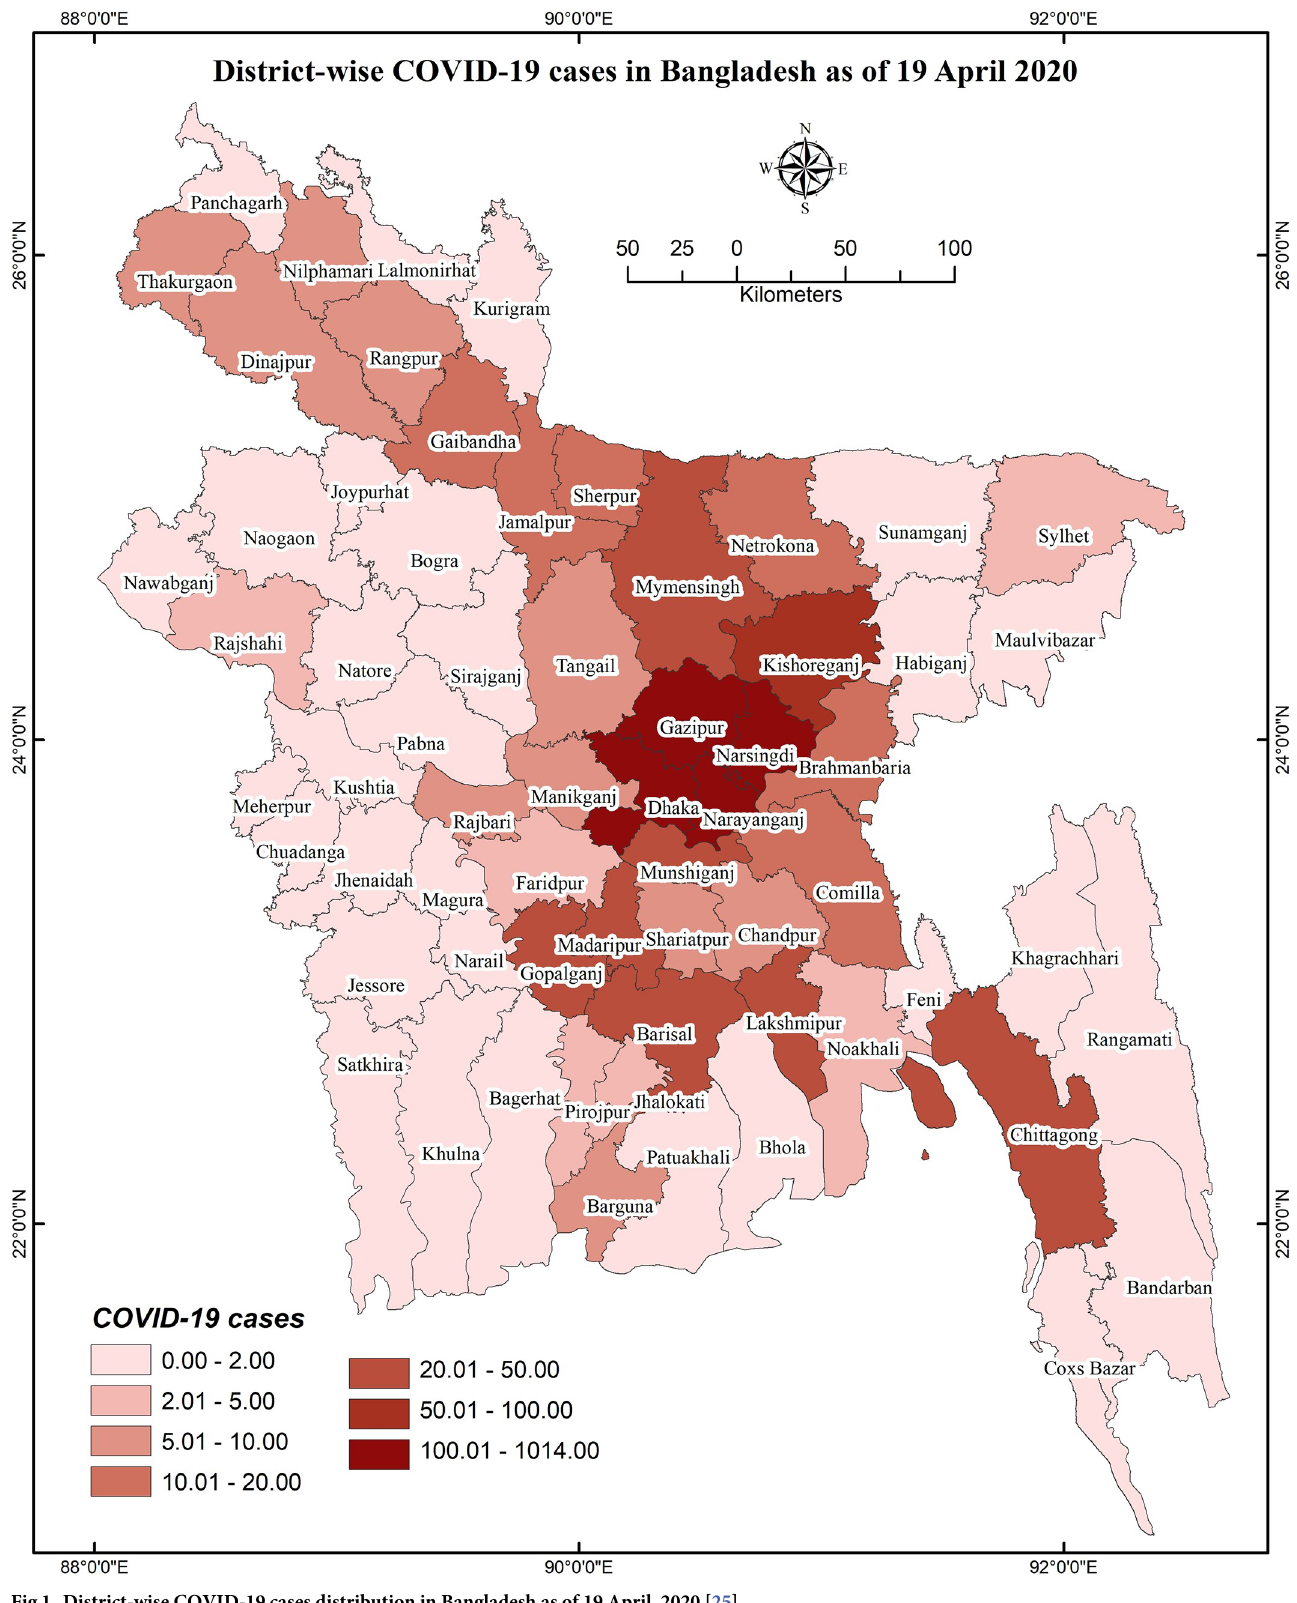
Fig 1. District-wise COVID-19 cases distribution in Bangladesh as of 19 April, 2020 [25].